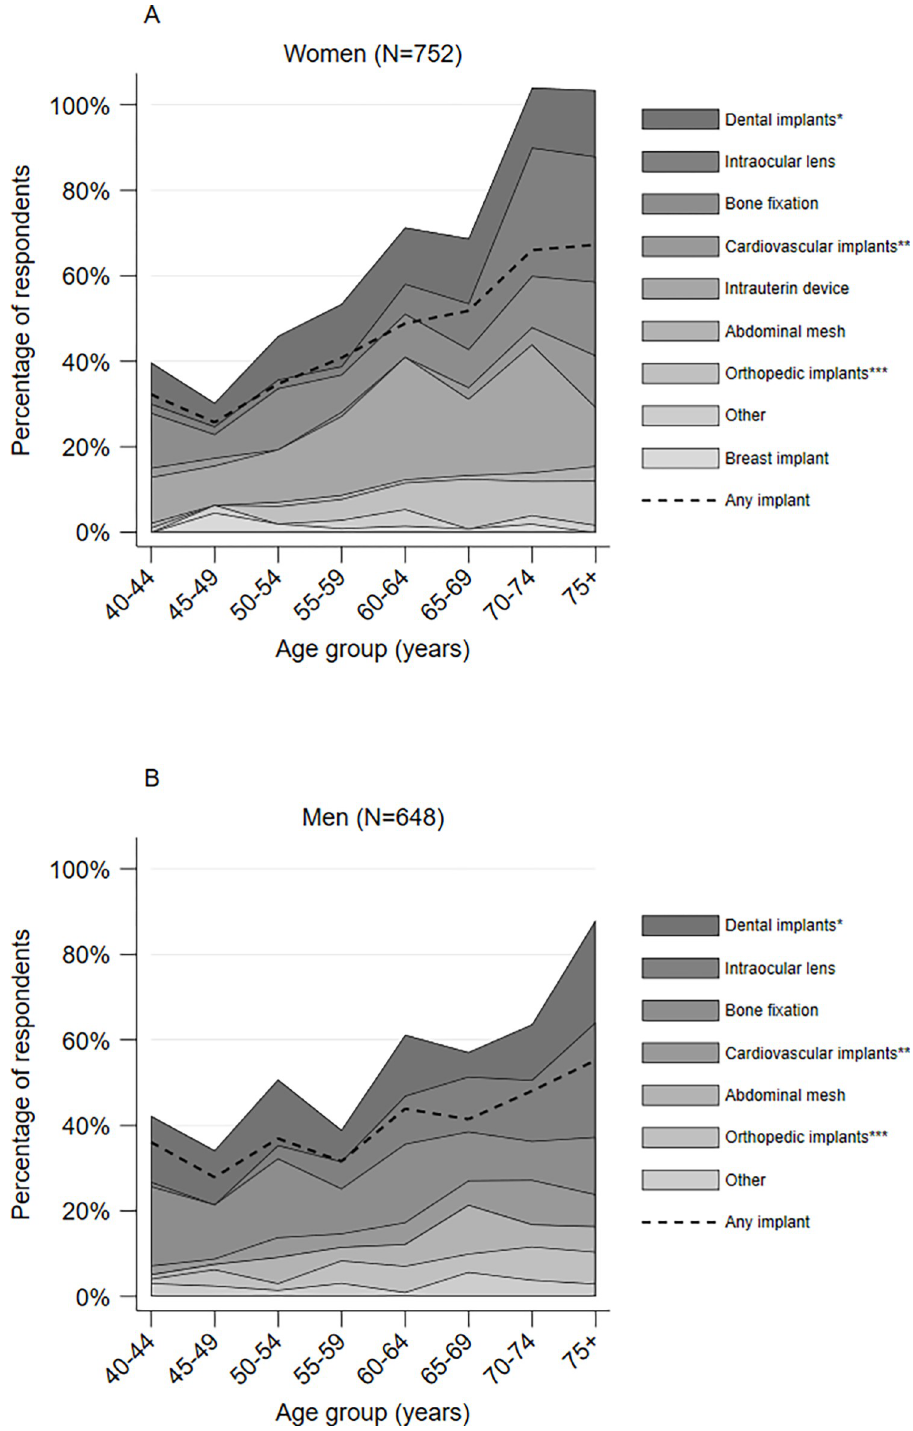
Fig 1. Distribution of ever received IMDs in the total sample by age groups and sex. * Dental implants inculde tooth implant and dental bone graft; ** Cardiovascular implants include pacemaker, artificial heart valve and coronary stent; *** Orthopedic implants include hip, knee and spine implants; Data for the category ‘glucose sensor’ are not presented as only four women cases were identified. Similarly, the category ‘breast implant’ is not included for men since only one case was